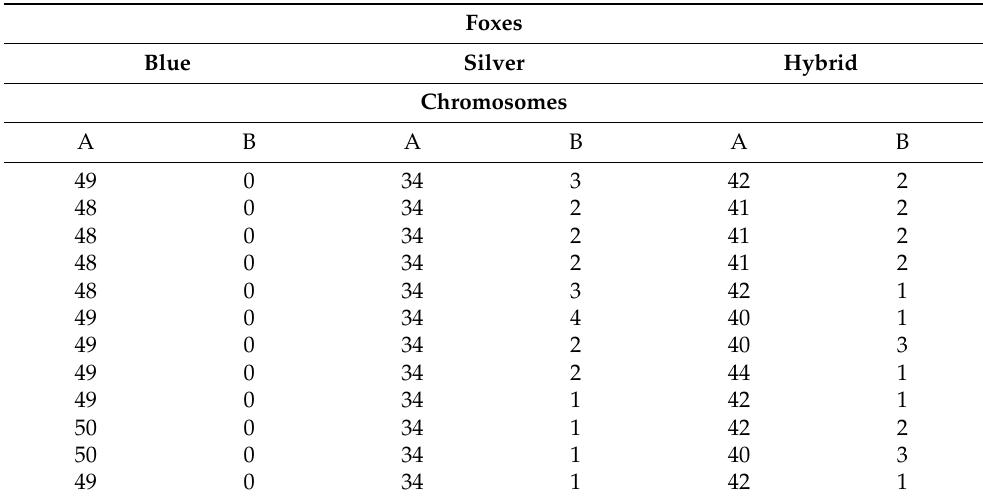
Table 1. Numbers of A and B chromosomes in the karyotypes of blue foxes, silver foxes, and their hybrids.